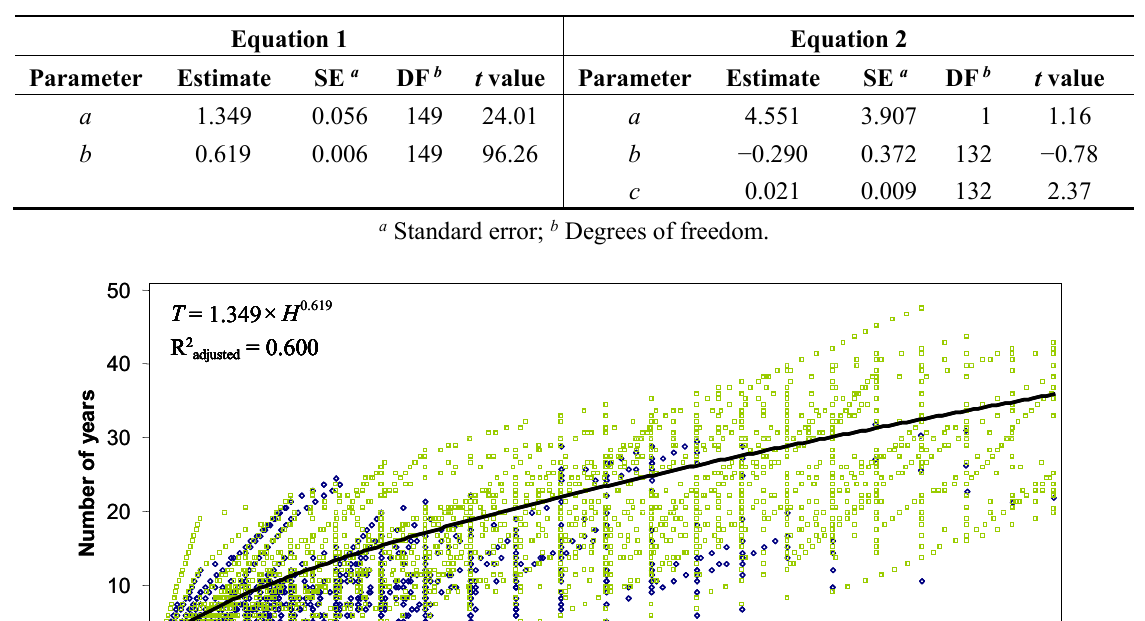
Table 4. Estimates and significance tests for parameters of Equations (1) and (2).